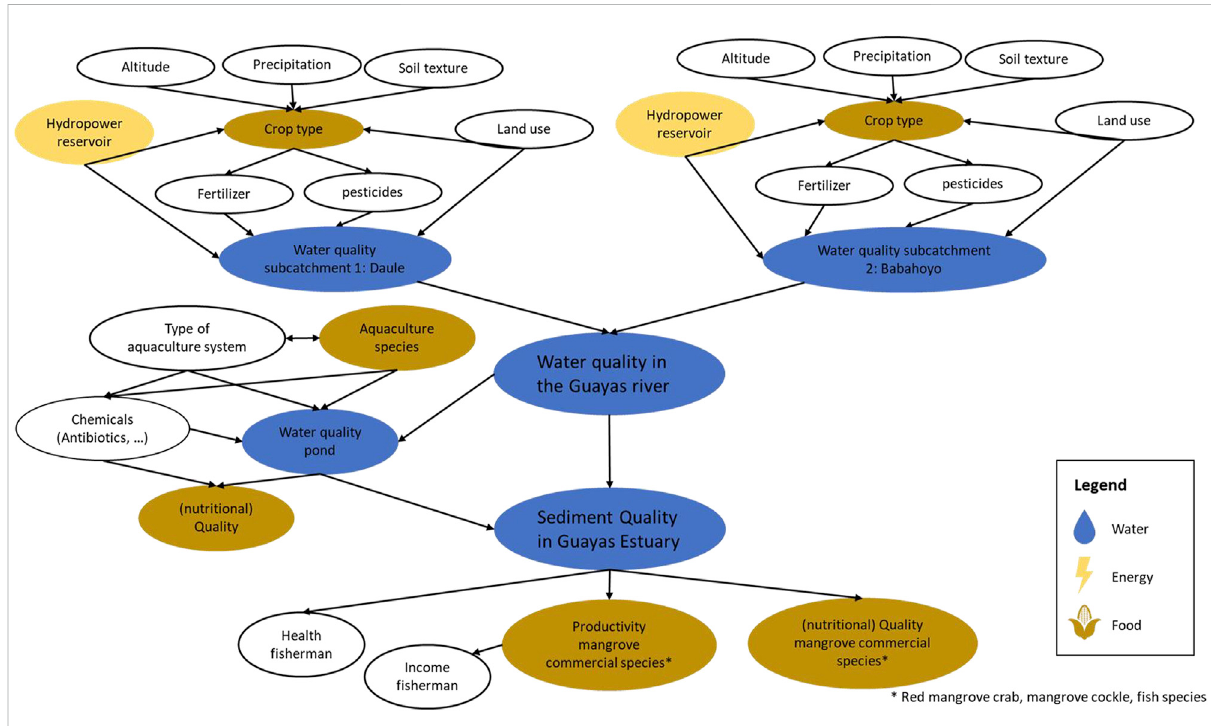
FIGURE 2 ConceptualdiagramoftheBayesianBeliefNetworkforthewater-energy-foodnexus,fromanecosystemperspective,intheGuayasriverbasin,